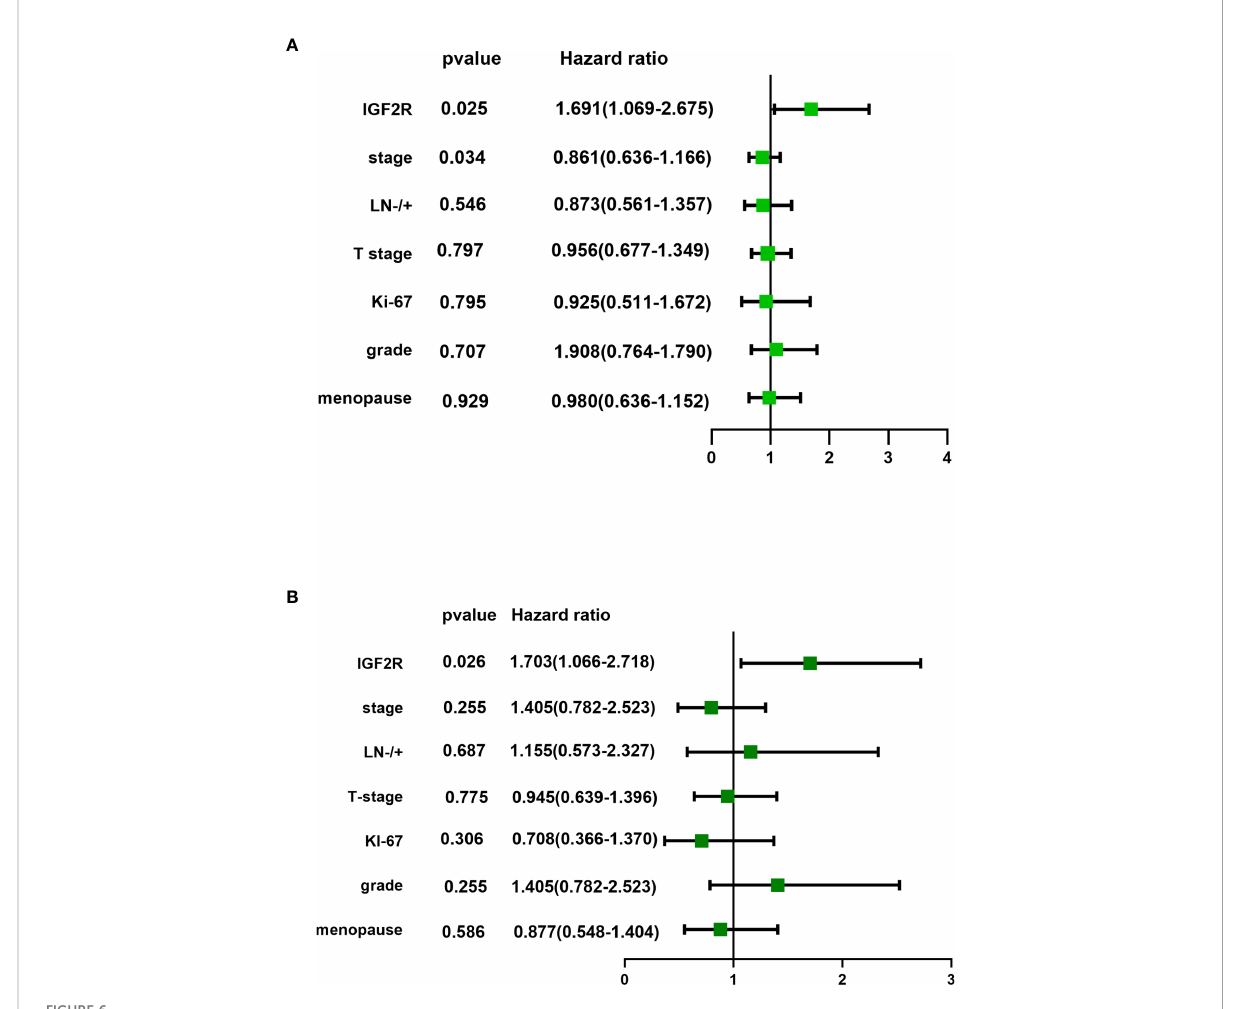
FIGURE 6 (A) Univariate analysis and (B) multivariate analysis of IFG2R expression and clinical characteristics for patients in the TNBC